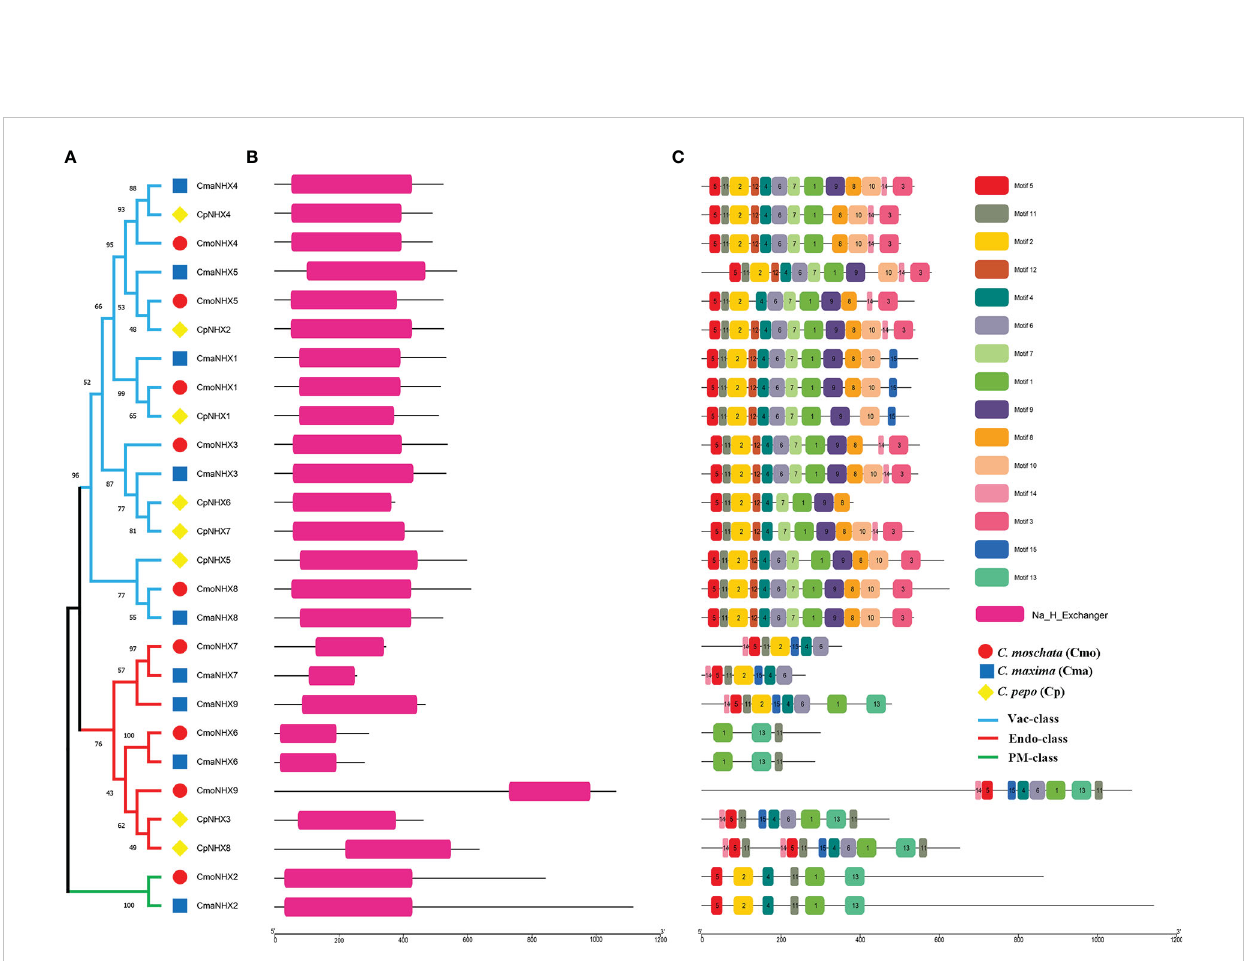
FIGURE 2 Structural analysis of 26 Cucurbita genera NHX proteins. (A) , Phylogenetic tree of NHX protein in 26 NHX proteins in Cucurbita genus. (B) , Conserved domains of 26 NHX proteins in Cucurbita genus. (C) , Motif analysis of 26 NHX proteins in Cucurbita